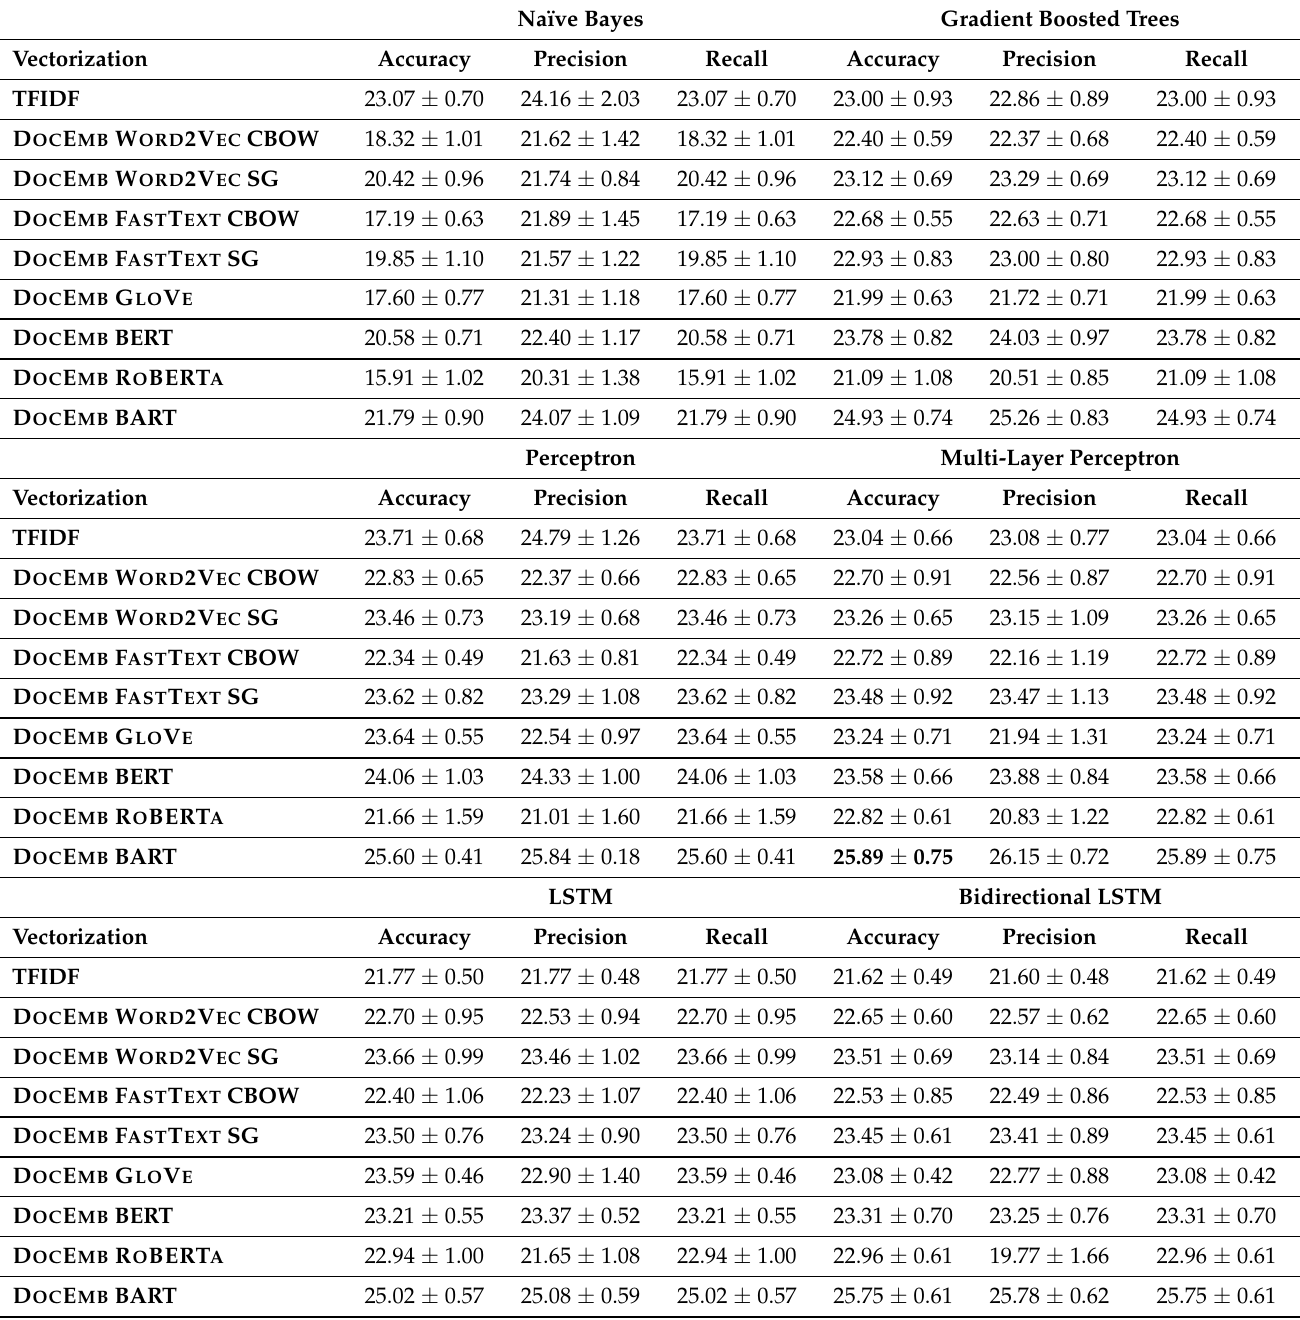
Table 3. Fake news detection results on Liar dataset with 6 labels as presented in Wang [10]. Naïve